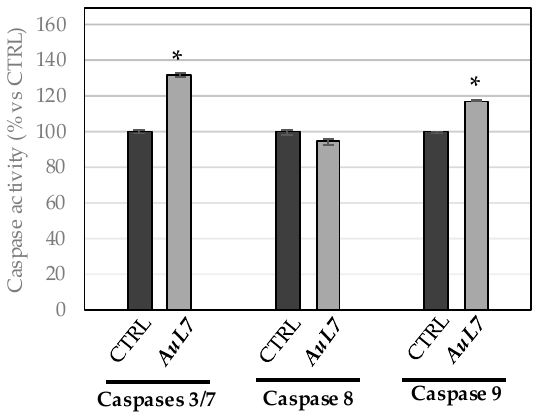
Figure 12. Caspases activity. Activation of caspases 3/7 and 9 due to the treatment of MDA-MB-231 cells with the compound AuL7 at a concentration equal to 5 μ M for 24 h. Columns mean, bars standard deviations (SD), * p < 0.001. Results are representative of three separate experiments.